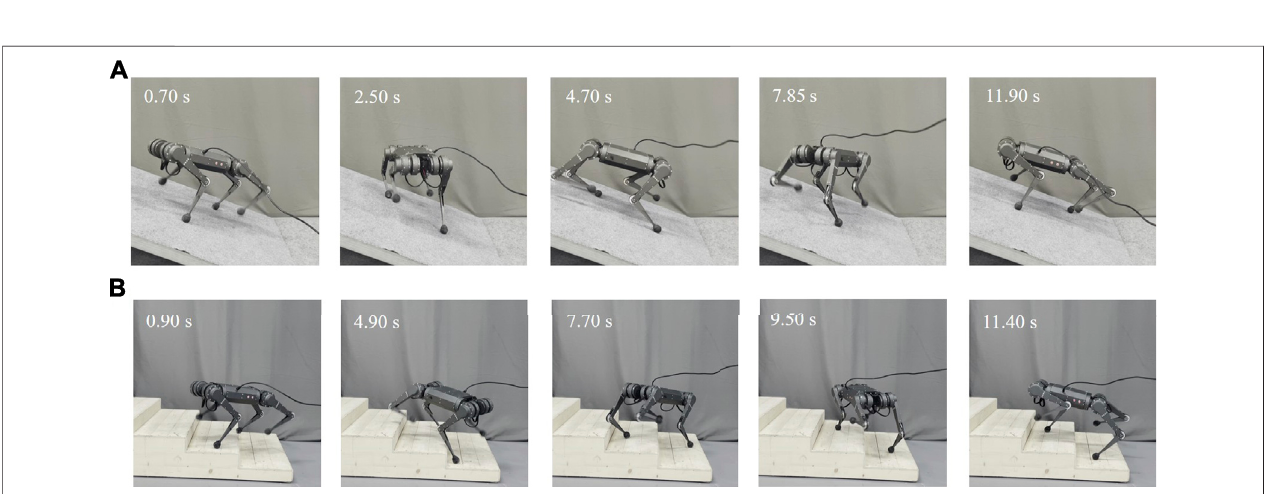
FIGURE 9 | Screenshots of the quadruped robot spinning on the (A) slope and (B) stairs with the proposed ASC method.